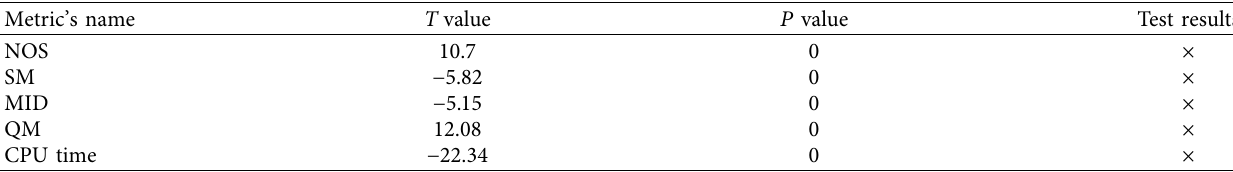
Figure 10: Comparison metrics for the standard NSGA-II (red boxes) and the modified NSGA-II (green boxes). Table 5: The P values of the paired t -test for different metrics.